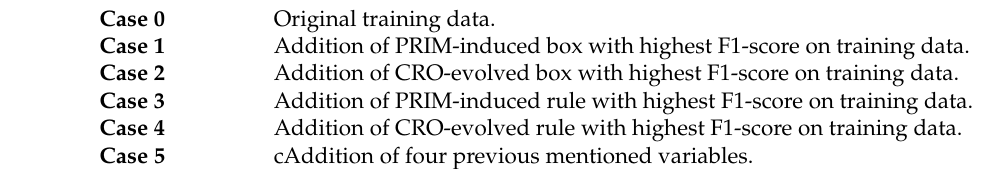
cAddition of four previous mentioned